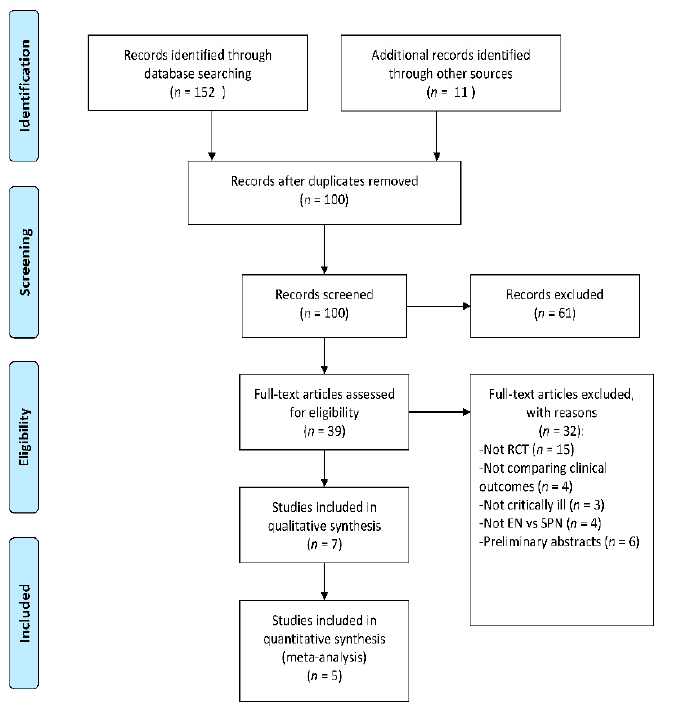
Figure 1. Flow diagram of the search strategy. Randomized controlled trials (RCT), Supplemental parenteral nutrition (SPN), Enteral nutrition (EN).